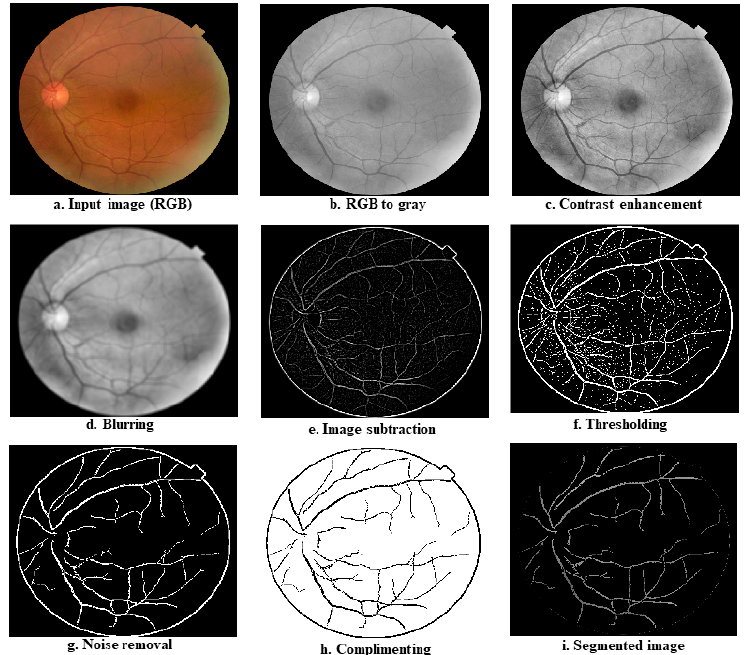
Figure 9. Transformations of input image (normal fundus) at various stages of the segmentation algorithm; ( a ) shows a sample image from the healthy class; ( b ) depicts a gray version of the image; ( c ) provides the image after contrast enhancement operation; ( d ) is the image after averaging operation; ( e ) is the image after subtraction; ( f ) is the image after thresholding operation; ( g ) is the image after noise removal; ( h ) is the image after complementing operation; and ( i ) is the segmented image.